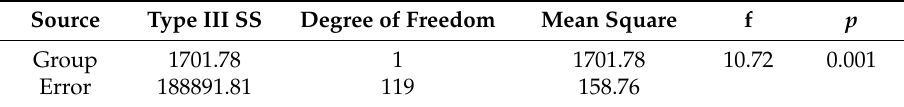
Table 4. ANCOVA results of students’ learning